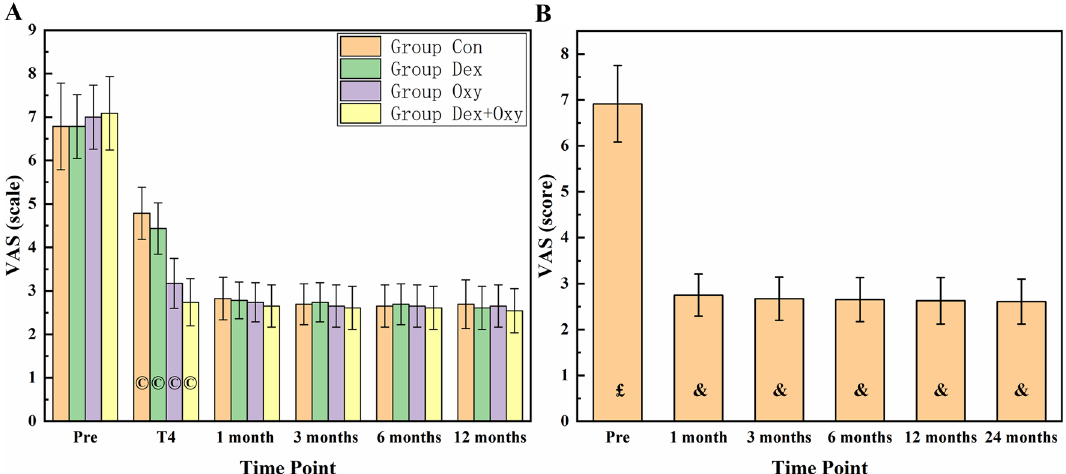
Figure 3. The results of the VAS score at different times of the four groups ( A ). VAS results in follow-up duration ( B ). "©" represents the differences were all statistical when compared with the other groups. "£" represents differences were all statistical when compared with the other time points. "&" represents differences was statistical only when compared with the time point of preoperation.